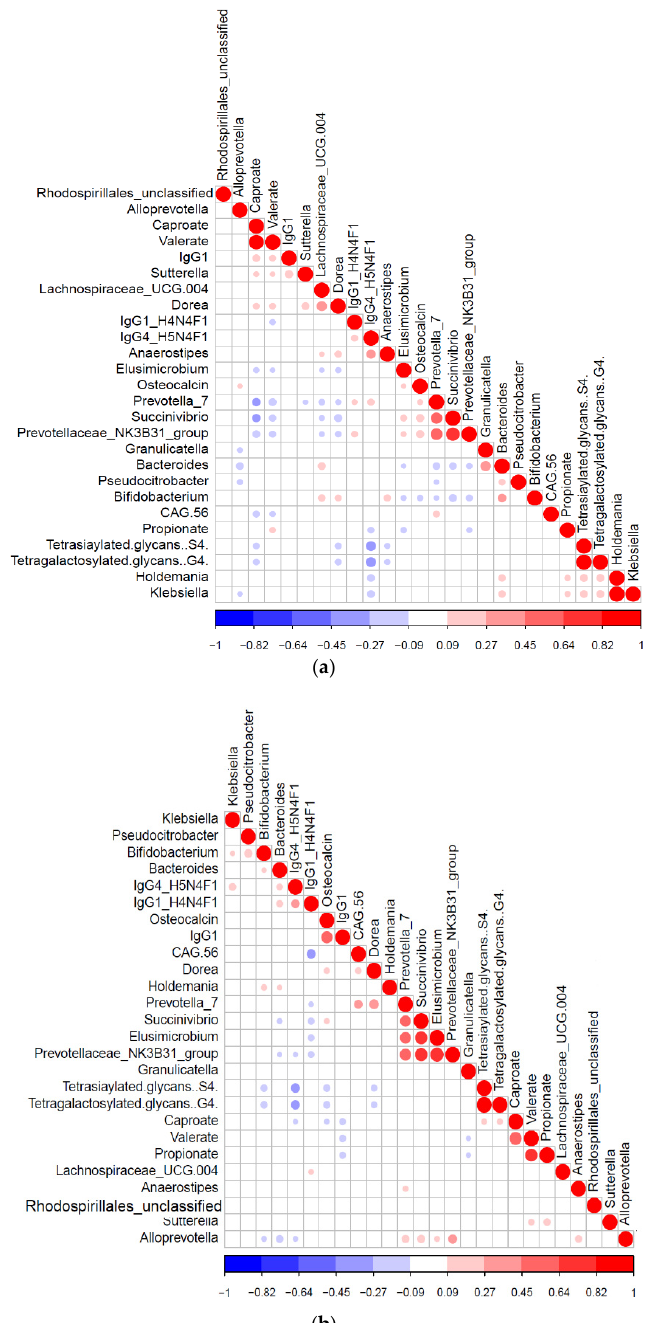
Figure 3. Significant Pearson correlation ( p < 0.05) of the selected features for the ( a ) rural ( n = 94) and ( b ) urban samples (124). Correlated variables are either highly positively correlated (in blue circles) or negatively correlated (red circles).